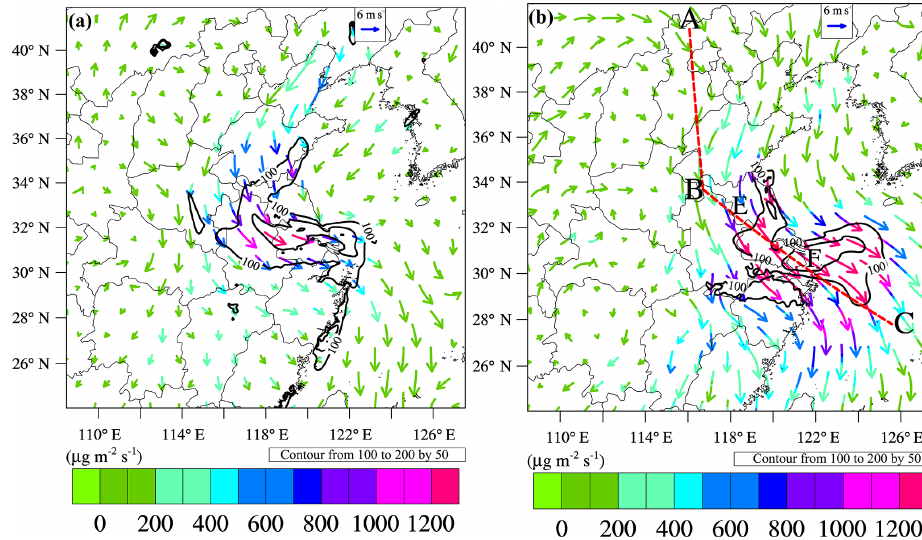
Figure 5. Mean wind vectors (arrow), PM 2 . 5 flux (coloured arrow), and mass concentration (black contours) at (a) the surface and (b) 1.0km altitude from 12:00LT 21 January 2015 to 04:00LT 22 January 2015. The dashed red line (A–B–C) in Fig. 5b denotes the location of the vertical cross section shown in Fig. 6. Points E and F indicate the YRD locations shown in Fig. 6.